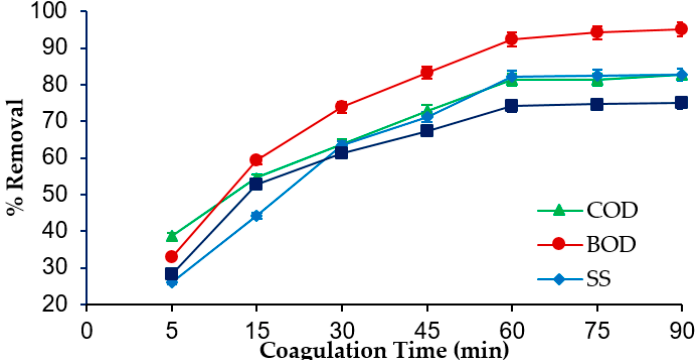
Figure 3. Influence of coagulation time on the removal of COD, BOD, SS, and NH 3 from SRPE using FeSO 4 ·7H 2 O as a coagulant. pH 5, doses 1 g/L, and sedimentation time 60 min.